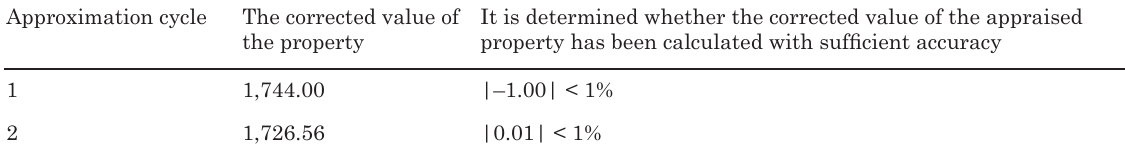
table 3. Estimation of changes in the mean deviation of the utility degree, the corrected value and the market value of the appraised